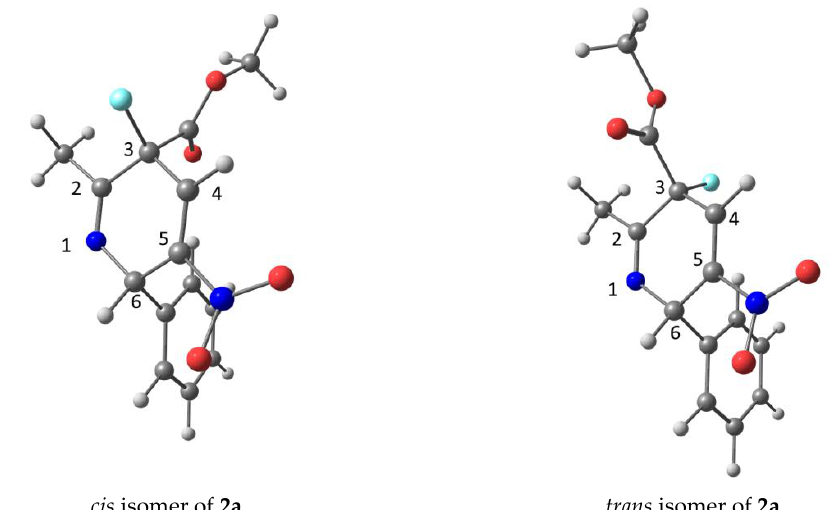
Figure 2. The structure of 2a optimised by density‒functional theory ( DFT) calculations. The optimised structures of 2b – k are provided in the supplementary materials as Gaussian output files.